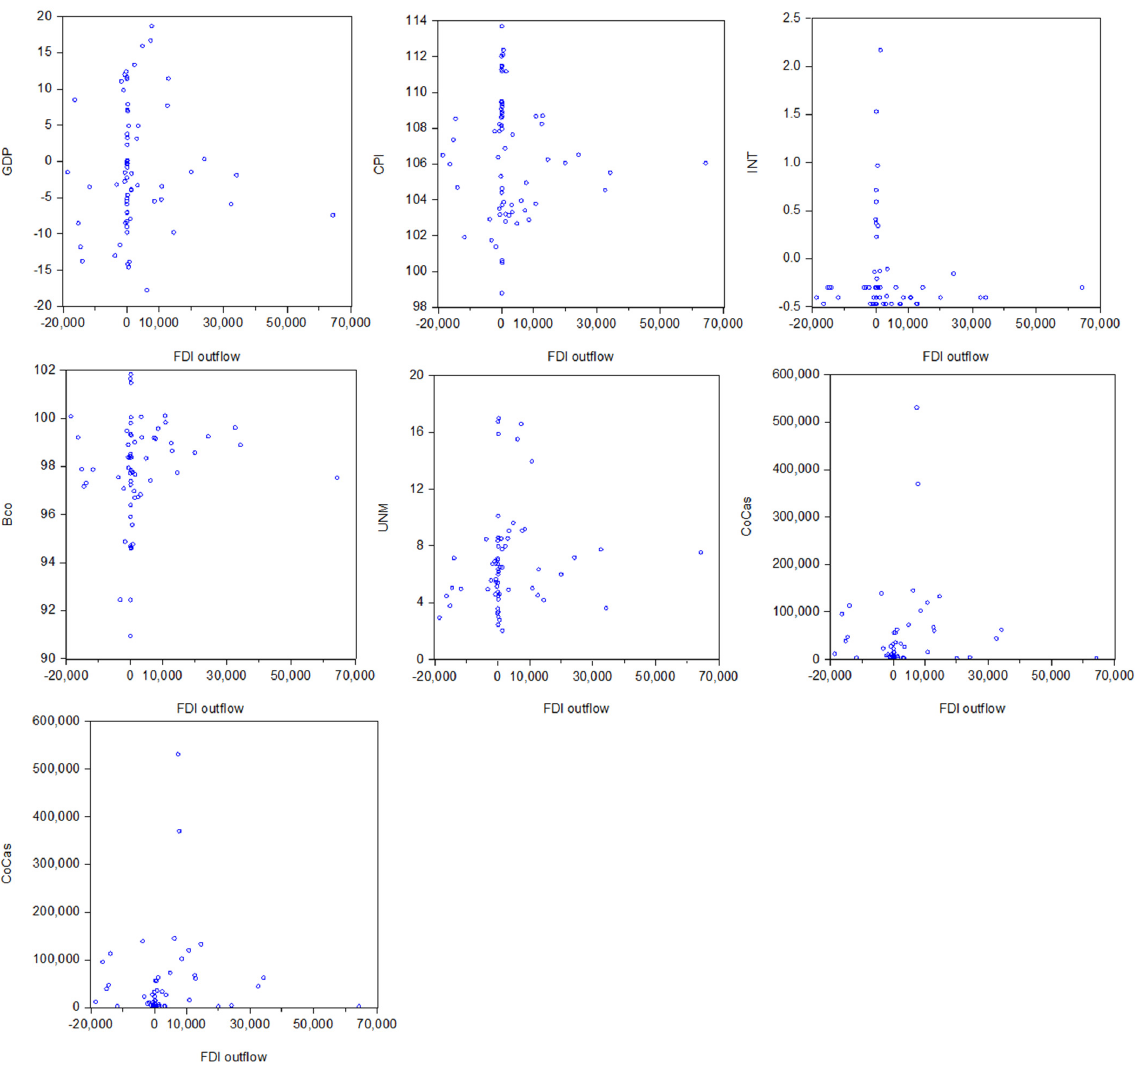
Figure 4. Scatterplots of FDI outflows and other variables.